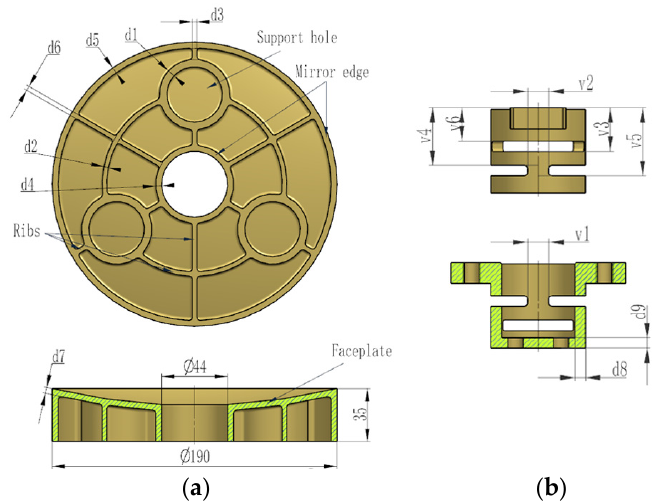
Figure 4. Design variables for size optimization. ( a ) Primary mirror. ( b ) Flexure.